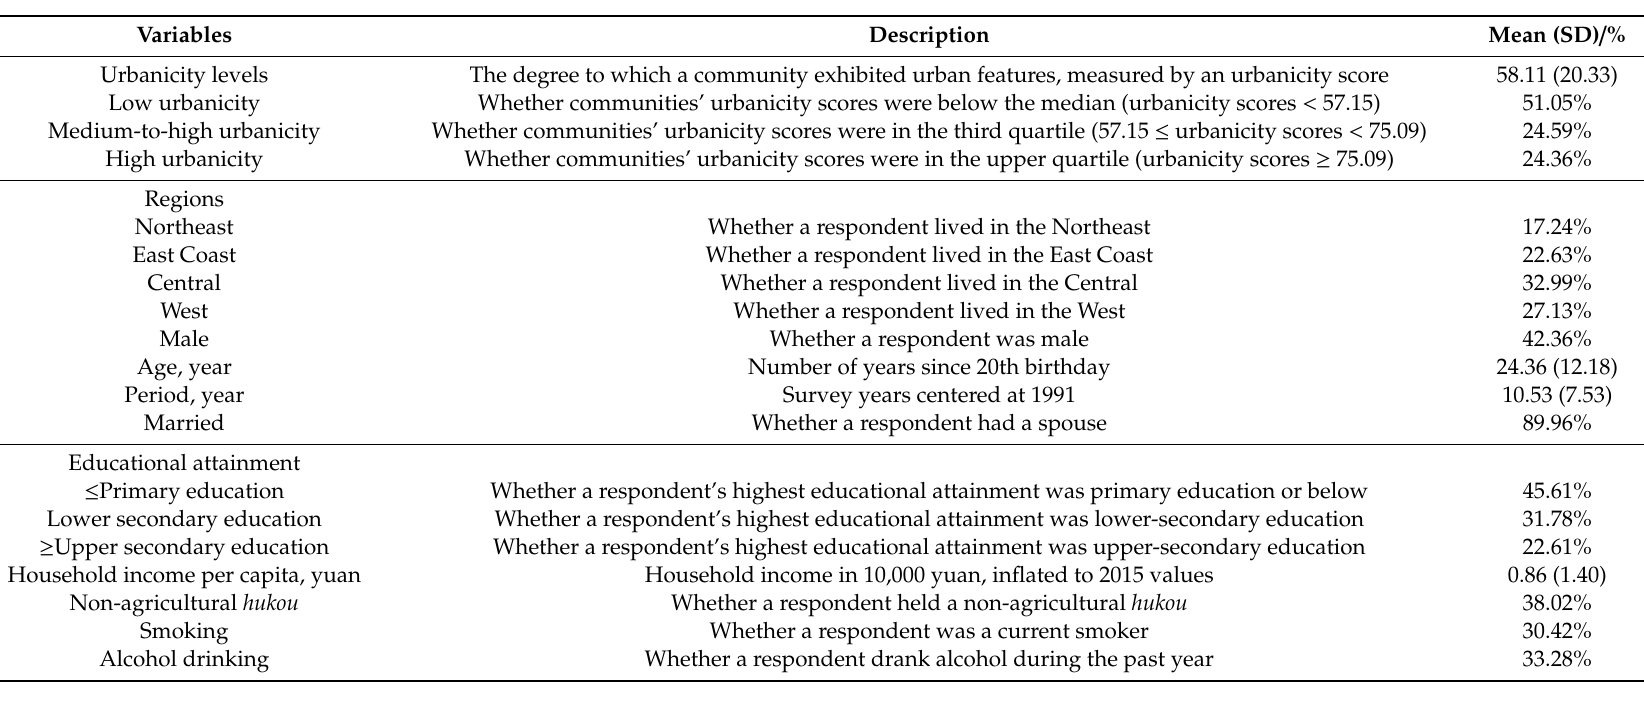
Table 1. Definitions and distributions of independent variables included in our analyses (N = 41,265 observations), China Health and Nutrition Survey